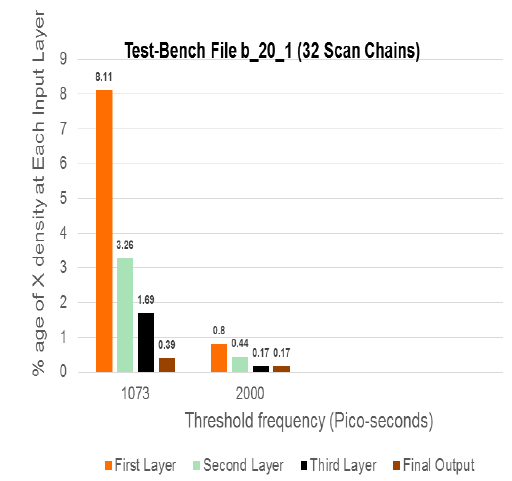
FIG. 12: TEST BENCH FILE B20_1(32 SCAN